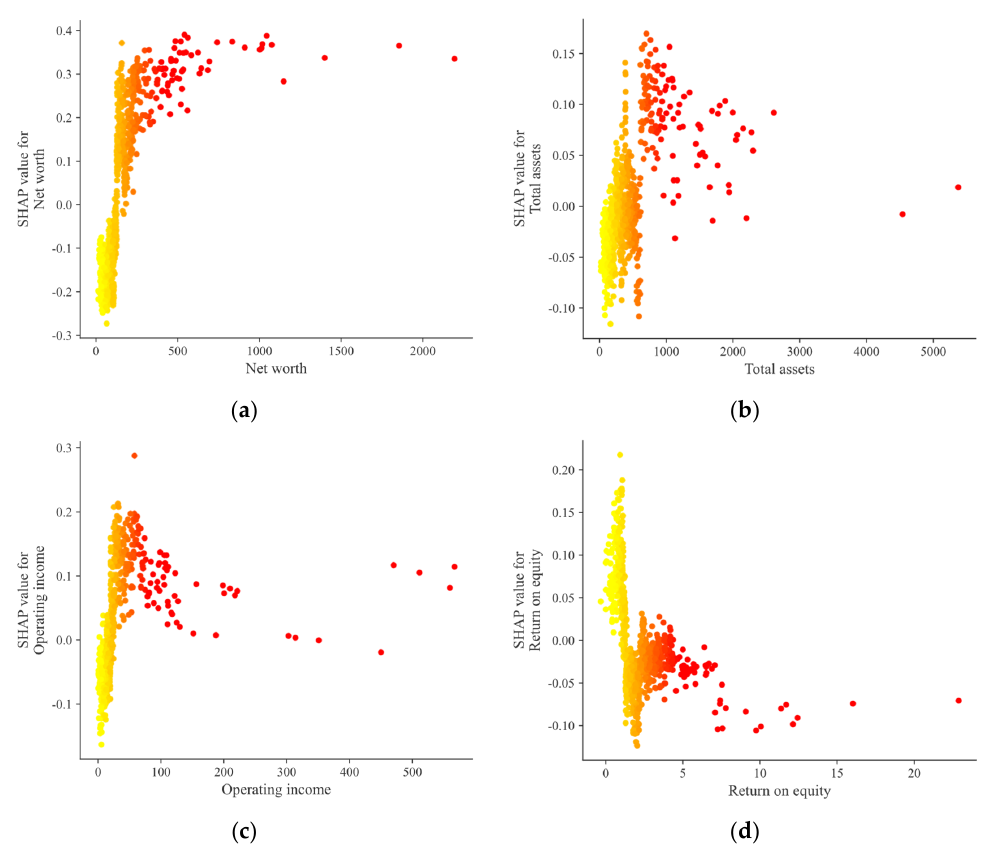
Figure 9. Impact analysis of the major variables. ( a ) Net worth; ( b ) total assets; ( c ) operating income; ( d ) return on equity.